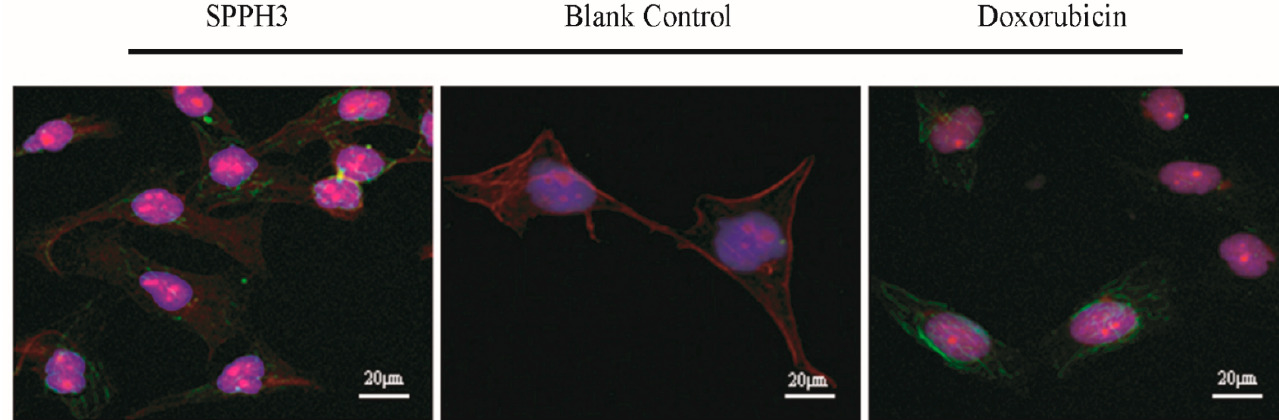
Figure 5. Cell morphology observed by LSCM after treatment with SPPH3 and Doxorubicin. LSCM images of MGC-803 cells incubated without (Blank Control) or with SPPH3 (0.31 mg/mL) or Doxorubicin (0.001 mg/mL) for 24 h, respectively. Cells were processed for indirect immunofluorescence assay to visualize the cytoskeleton which was stained for actin filaments (red), microtubules (green) and nuclei (blue). Images were captured by an LSCM at × 630 magnification. All three stains are superimposed. Scale bar = 20 µ m.